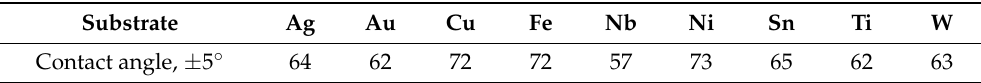
Table 1. The measured contact angle on the surface of pure metals.